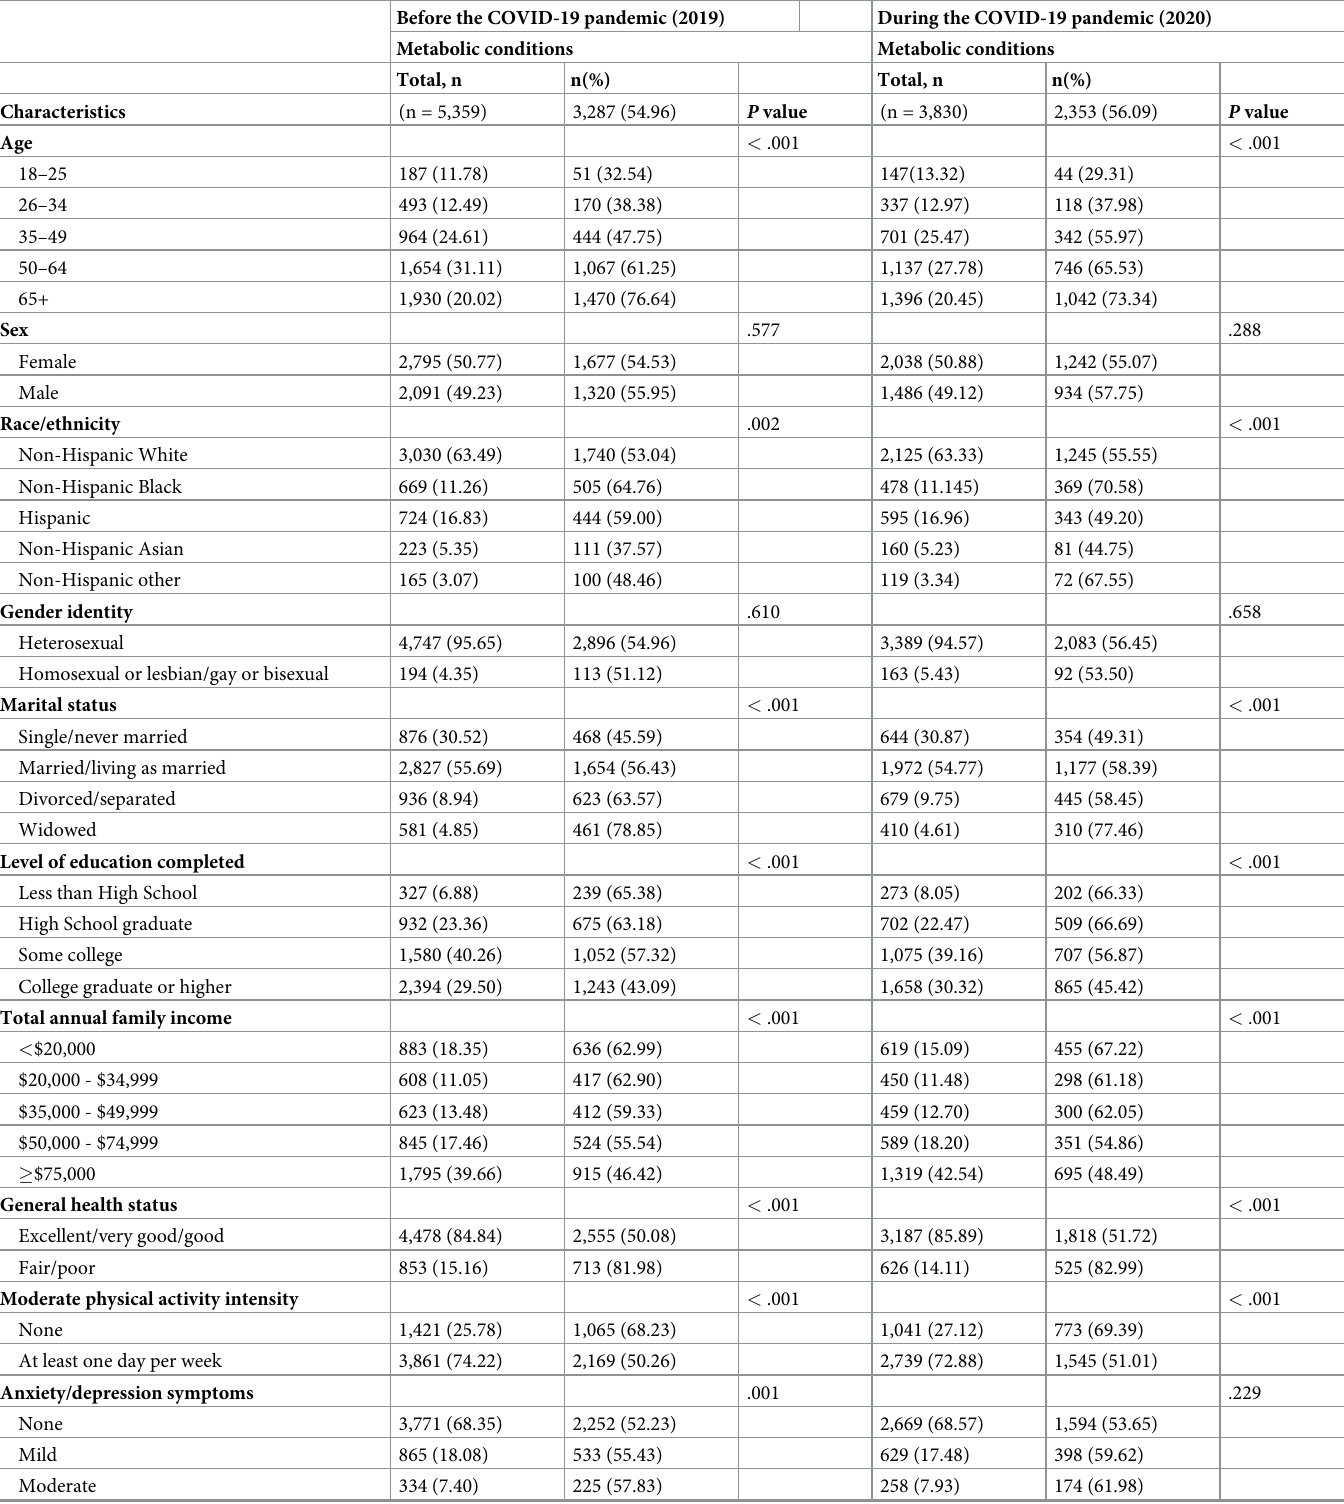
Table 1. Demographic characteristics of U.S. adults before and during the COVID-19 pandemic and association with metabolic conditions (N = 9,189). Before the COVID-19 pandemic